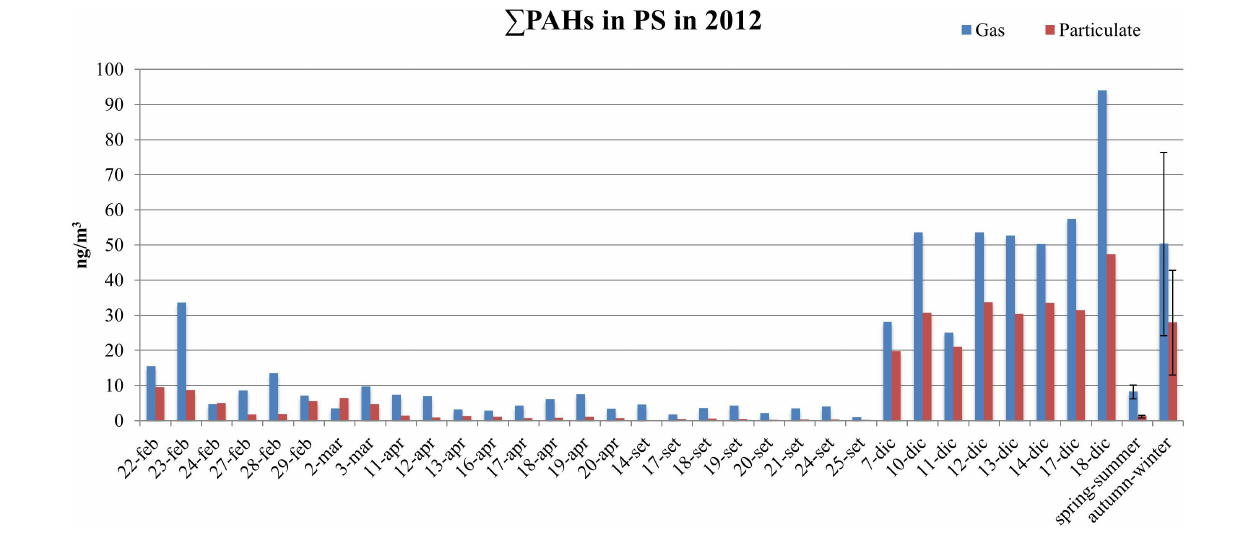
FIGURE 5 | Trend of (cid:54) PAHs in particulate and gas phase, in PS site, for the year 2012, with averages and standard deviations as error bars.